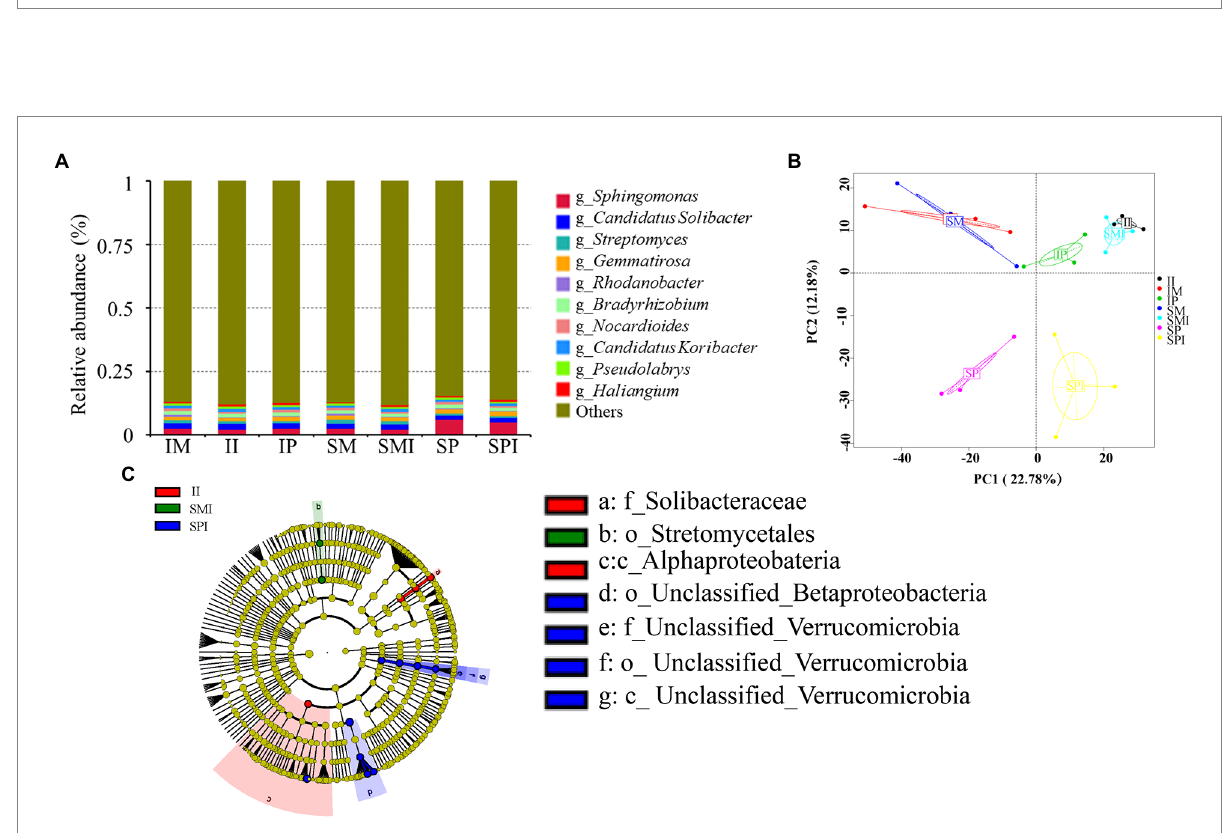
FIGURE 5 Composition and distribution of bacterial communities at the genus level under different planting patterns. (A) Histogram of the relative abundance of bacterial communities. (B) Principal component analysis (PCA) of bacterial community. (C) LEfse analysis. SM: sole maize, IM: intercropped maize, SP: sole peanut, IP: intercropped peanut, SMI: the shared soil of sole maize, SPI: the shared soil of sole peanut, II: the shared soil of intercropped maize and